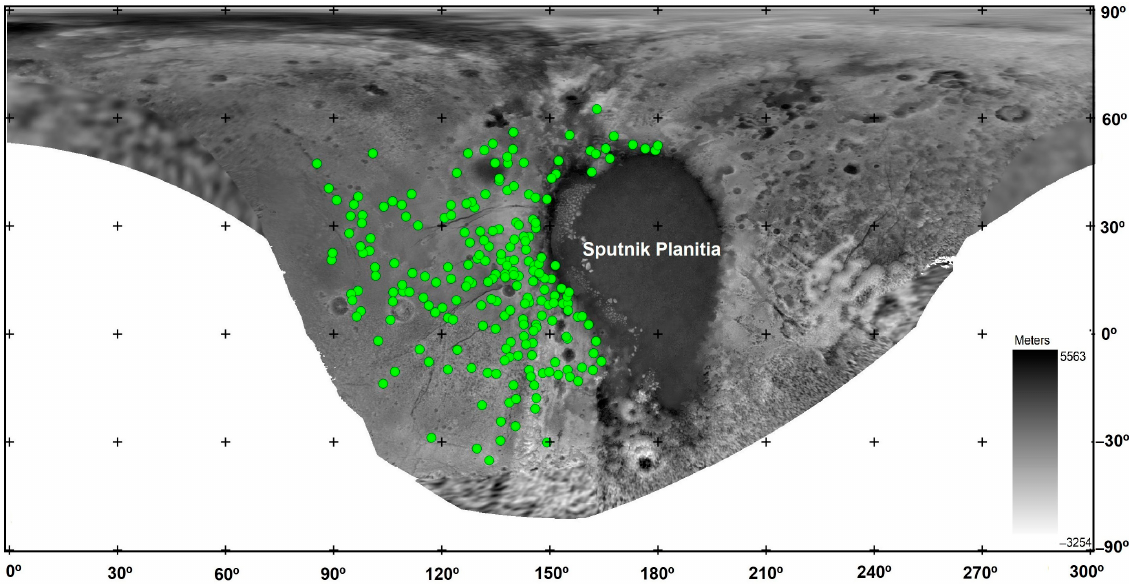
Figure 2. DEM of Pluto ’ s surface [8], [11]. Dots represent the 237 craters analyzed in this work (Table S1).